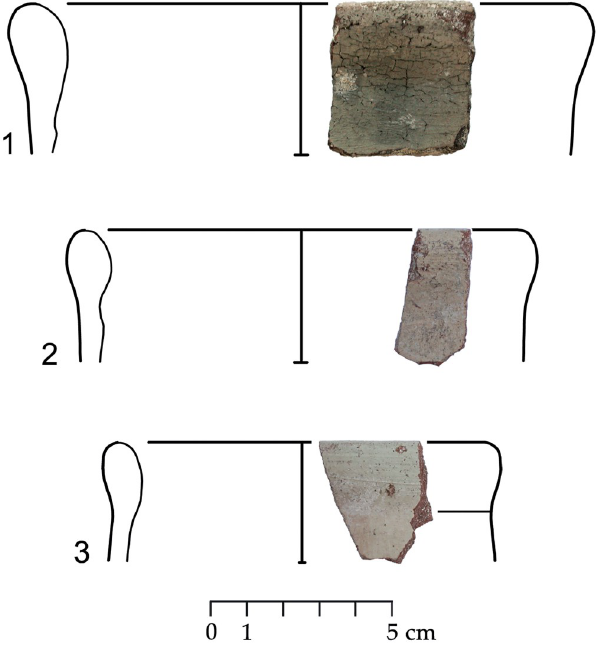
Fig 47. Amphora rims from Room 6: 1. S/125699/4510; 2. S/123892/4496; 3. S/120575/4446.